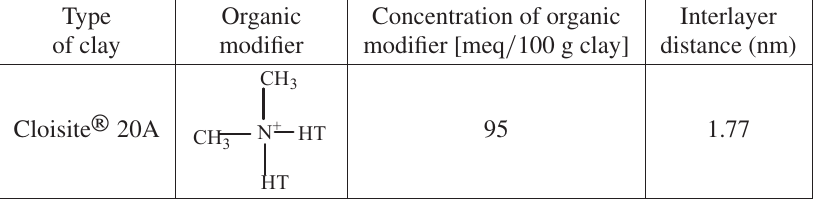
Table 1. Organic modifiers and Interlayer Distance of the clays.